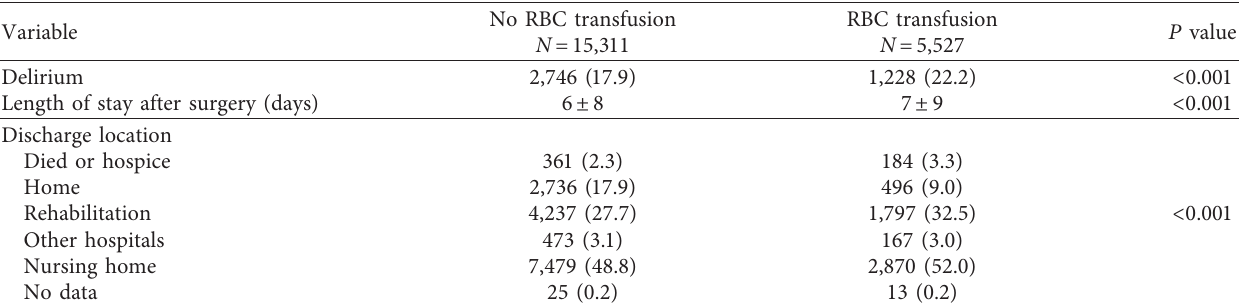
Table 2: Outcomes for all patients with eligible CPTs and complete study